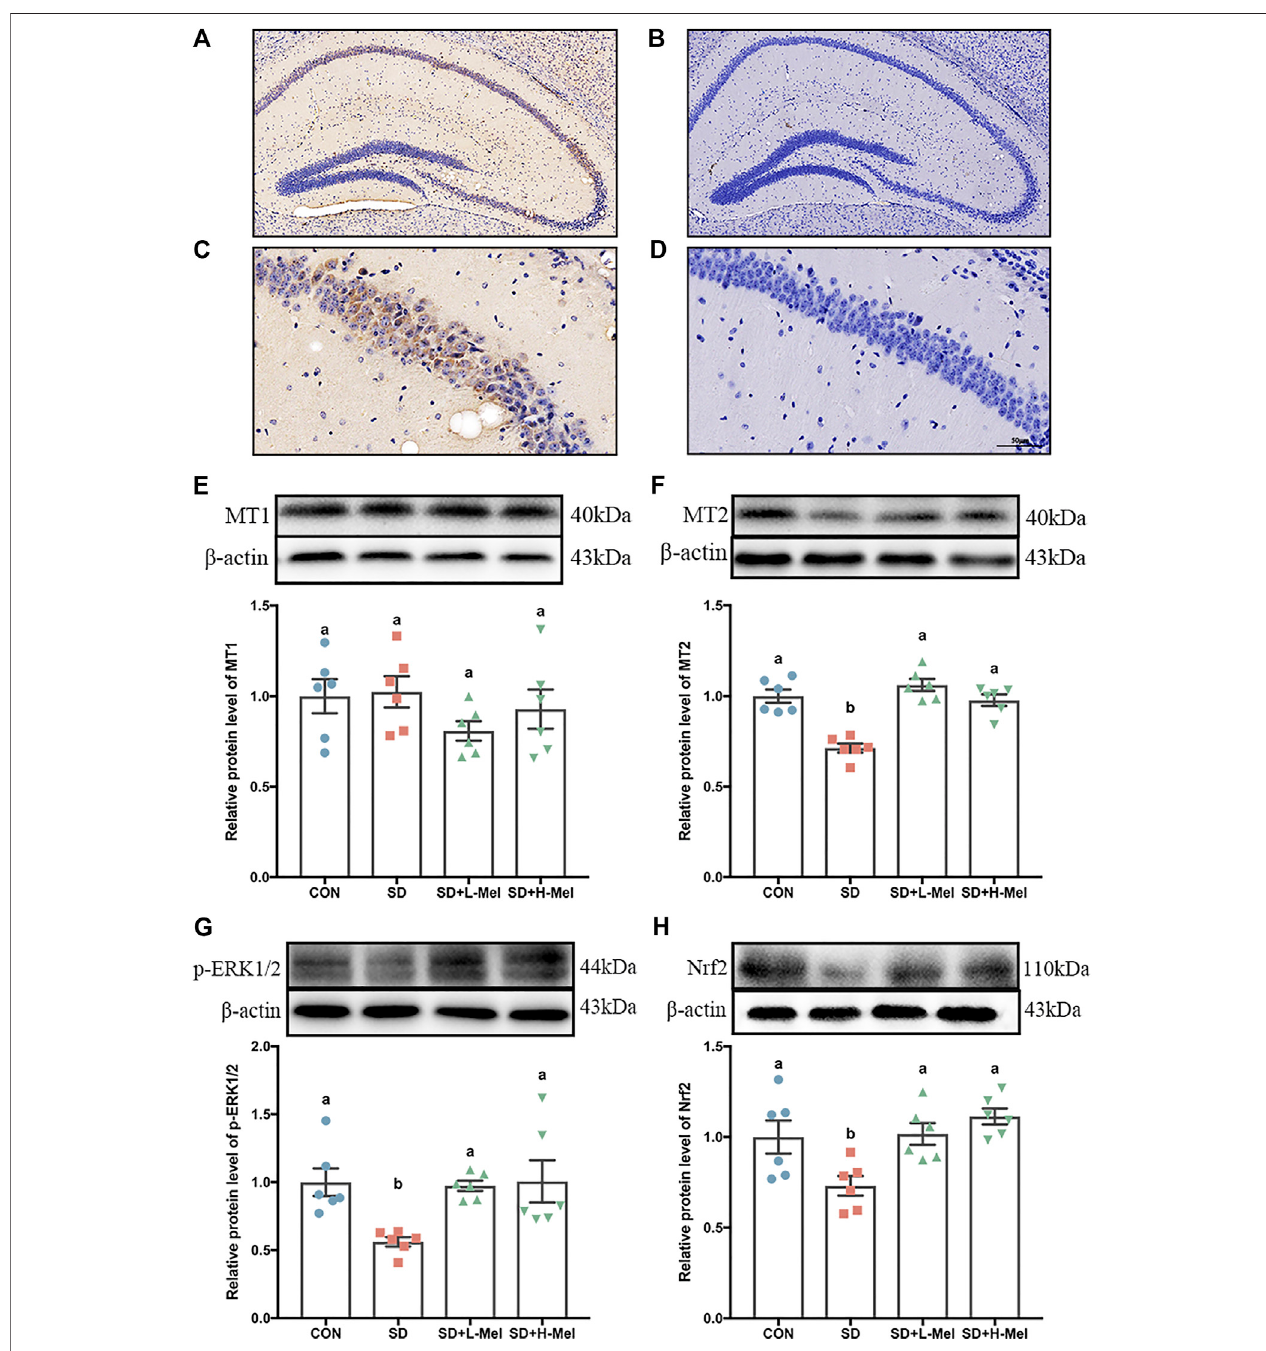
FIGURE 5 | Effect of melatonin on MT2/ERK/Nrf2 signaling in the hippocampus of sleep-deprived mice (A, C) Immunohistochemical staining of MT2 in hippocampus. Brown indicates positive cells. (B, D) negative control. A – B: bar (cid:1) 200 μ m; C – D: bar (cid:1) 50 μ m. (E – H) Relative protein levels of MT1, MT2, p -ERK1/2 and Nrf2 were normalized to β -actin ( n (cid:1) 6). Differences were assessed using one-way ANOVA. The result represents the mean ± standard error of the mean. Values not sharing a common superscript letter differ signi fi cantly at p < 0.05; those with the same letter do not differ signi fi cantly ( p ≥ 0.05). CON: control group, SD: sleep deprivation group, SD + L-Mel: SD + low melatonin (20 mg/kg) supplement group, SD + H-Mel: SD + high melatonin (40 mg/kg) supplement group.